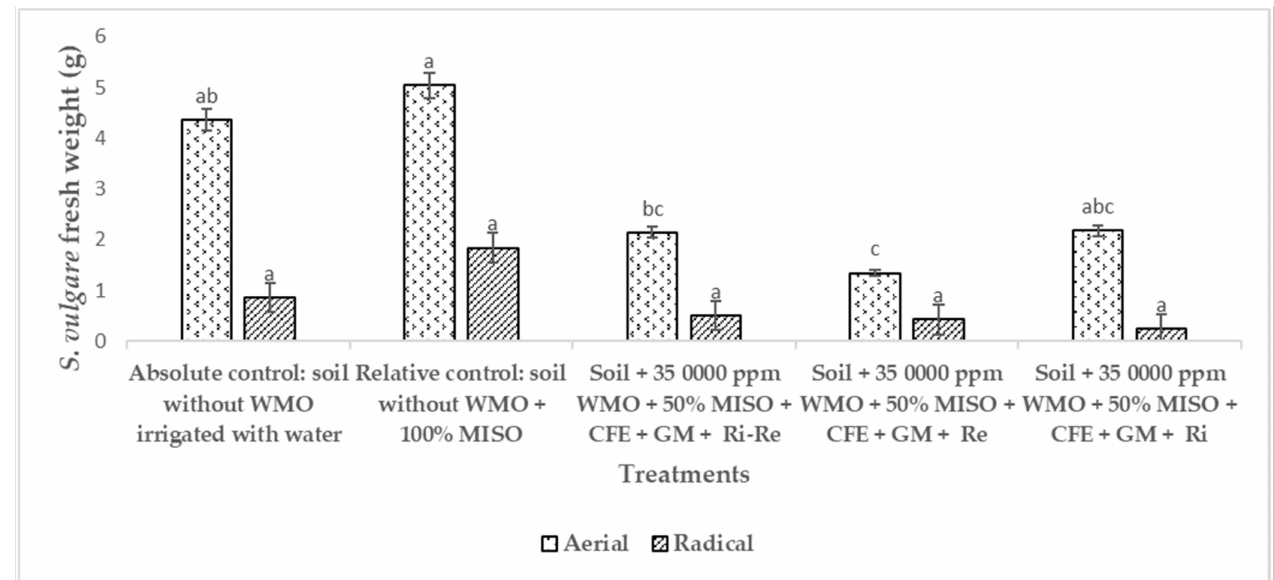
Figure 4. Aerial and radical fresh weight of Sorghum vulgare inoculated with Rhizobium etli and Rhizophagus irregularis after 120 days of phytoremediation of soil polluted by remaining waste motor oil. Notes: CFE = crude fungal extract, GM = green manure, MISO = mineral solution, Ri = Rhizophagus irregularis , Re = Rhizobium etli , WMO = waste motor oil. Distinct letters indicate statistical